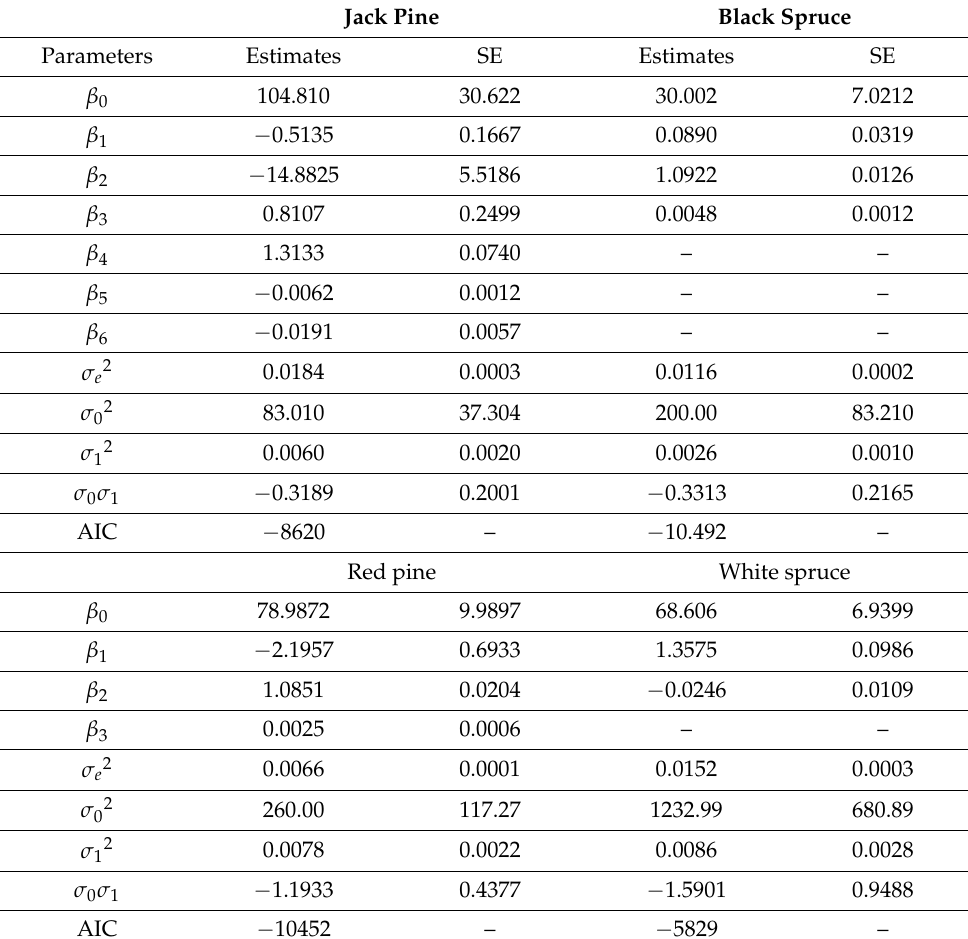
Table 2. Parameter estimates, their standard errors (SE), and fit statistics (MSE ( σ e 2 ), variance of b 0 ( σ 02 ), variance of b 1 ( σ 12 ), covariance of b 0 and b 1 ( σ 0 σ 1 ), and the Akaike information criterion (AIC) for the models with climate variables (Equations (2)–(5)) for jack pine, black spruce, red pine, and white spruce trees grown in plantation across Ontario, Canada. Jack Pine Black Spruce Parameters